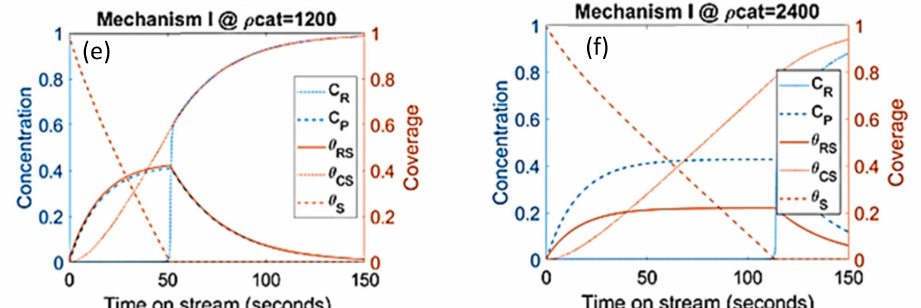
Figure 9. Estimated reactant and product concentration profiles ( left axis ) and surface species coverages ( right axis ) with respect to time: showing the effect of increasing catalyst amount. ( a ): ρ cat = 600 g cm − 3 . ( b ): ρ cat = 750 g cm − 3 . ( c ): ρ cat = 900 g cm − 3 . ( d ): ρ cat = 1050 g cm − 3 . ( e ): ρ cat = 1200 g cm − 3 . ( f ): ρ cat = 2400 g cm − 3 .